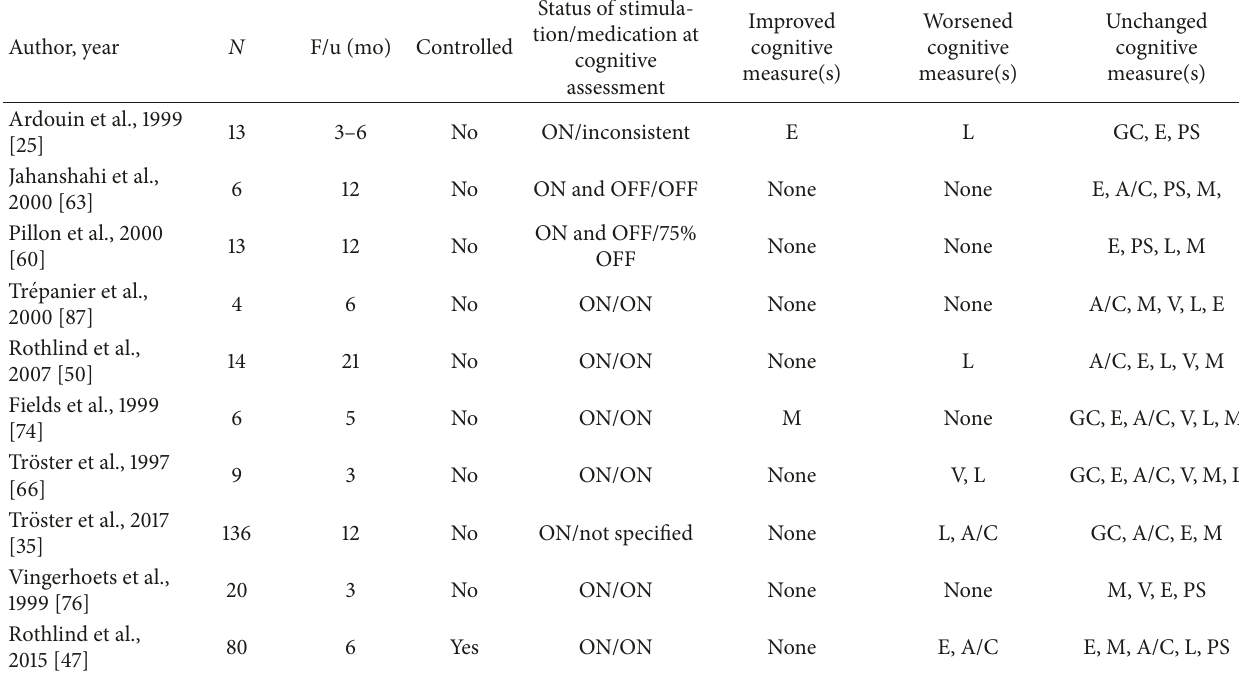
Table 2: Studies assessing cognitive change in PD patients after GPi